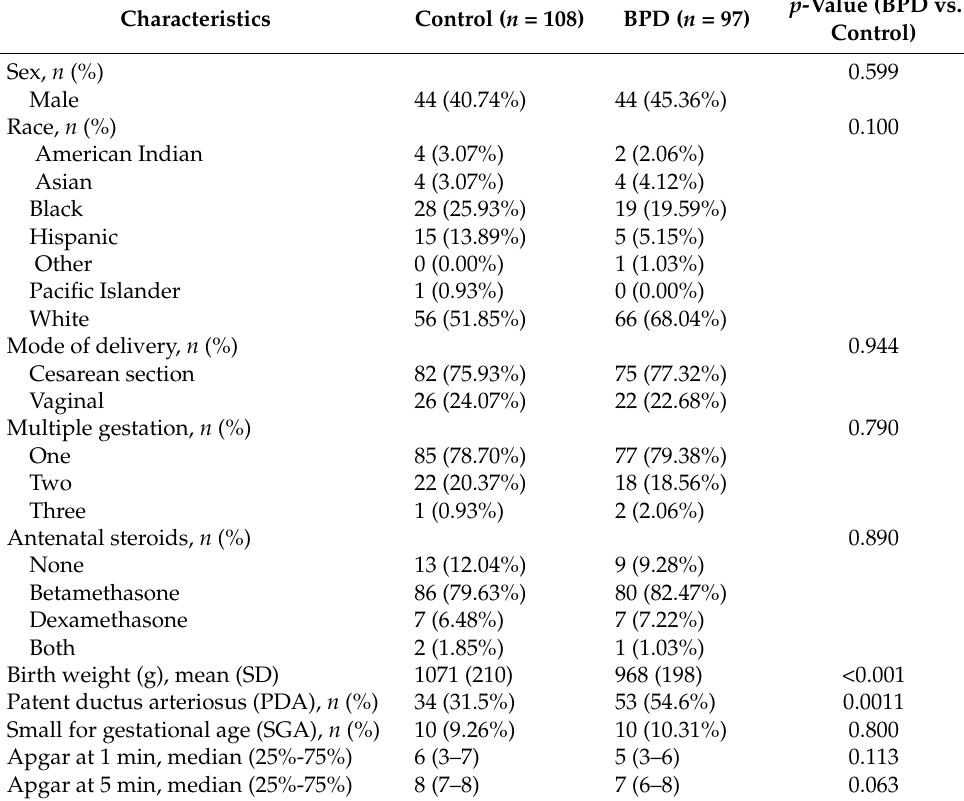
Table 1. Demographics and characteristics of the sub-cohort with GA of 27–28